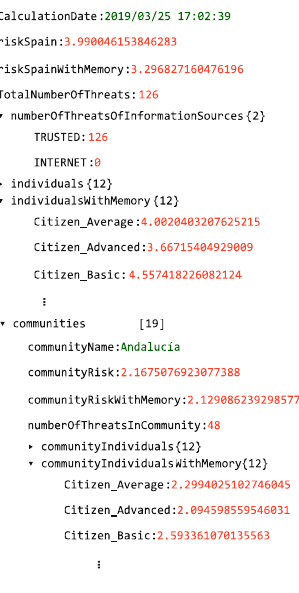
Figure 9. Example of JSON generated at the end of a measurement.